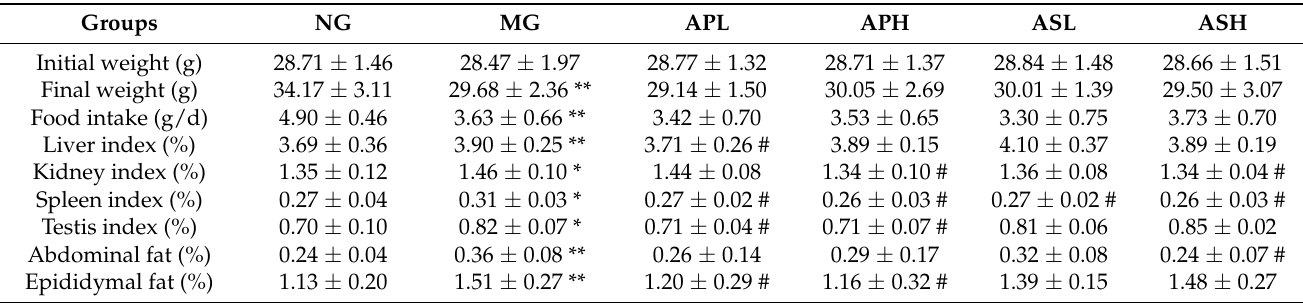
Table 2. Effects of AP and AS on body weight, food intake, and organ and fat index of mice 1 . Groups